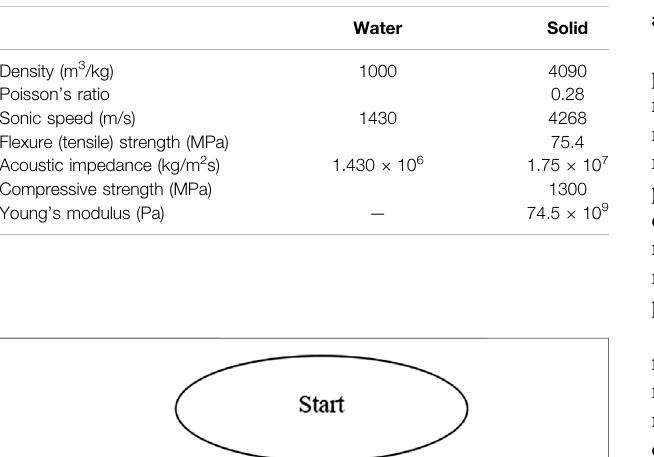
TABLE 1 | the physical properties involved in the calculation.